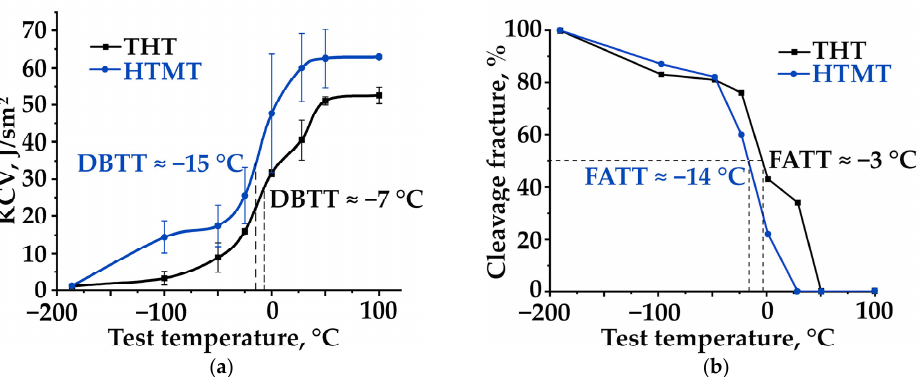
Figure 10. Temperature dependences of impact toughness ( a ) and brittle fracture ( b ) of steel EK-181 after THT and HTMT in the temperature range from 100 to − 186 °C. DBTT—Ductile-Brittle Transition Temperature. FATT—Fracture Appearance Transition Temperature.